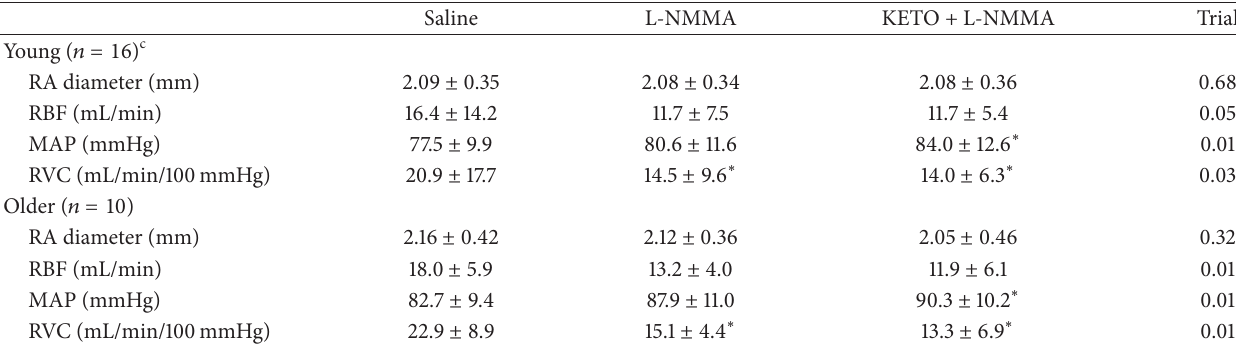
Table 2: Baseline hemodynamics across infusion trials in young and older adults a,b